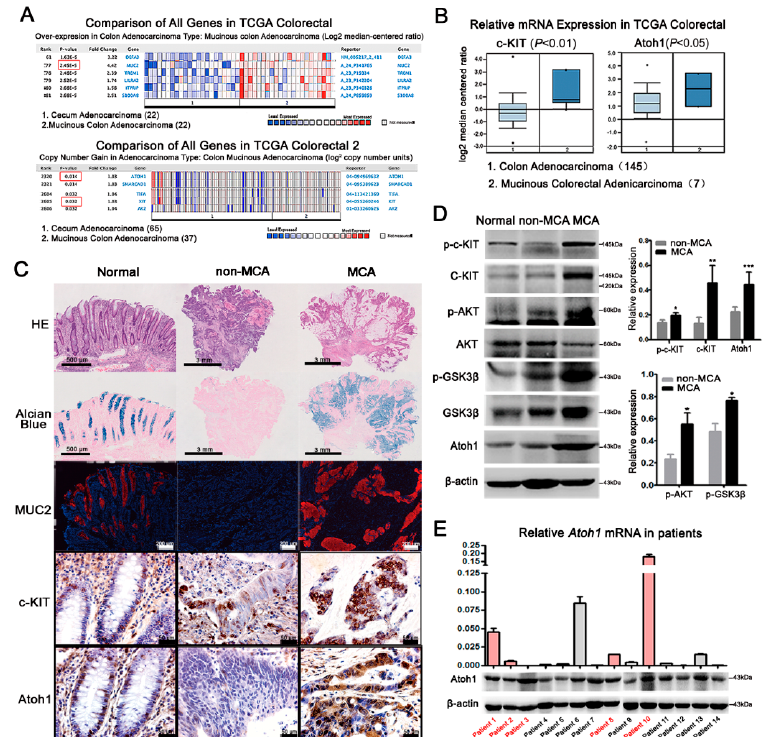
Figure 4. Expressions of c-KIT and Atoh1 in CRC patients. ( A ) Compared with cecum adenocacinoma ( n = 22), mRNA levels of MUC2 was markedly increased in mucinous colon adenocarcinoma ( n = 22) in TCGA Colorectal (red boxes, p -value). DNA copies of c-KIT and Atoh1 were significantly increased in mucinous colon adenocarcinoma ( n = 37) indicated by TCGA Colorectal 2; ( B ) the mRNA levels of c-KIT and Atoh1 were also elevated in MCA patients ( n = 145) compared with non-MCA ( n = 7) from TCGA Colorectal. p < 0.05 or 0.01; ( C ) according to the mucus area estimated under HE and Alcian blue staining, human CRC tissues were divided into non-MCA and MCA. Paratumoral normal tissues were used as controls. MUC2 was filled in goblet cells in normal colon and the main mucus component in MCA, while there was rare MUC2 in non-MCA tissues. Normally, c-KIT was expressed in the membrane while Atoh1 in the nuclei of epithelial cells, including goblet cells. Compared with non-MCA, c-KIT and Atoh1 were remarkably elevated in MCA, indicated by much more intensive immunostaining; ( D ) protein expressions of total c-KIT, p-c-KIT, and Atoh1 were clearly higher in MCA patients ( n = 5) than those in non-MCA patients ( n = 9) combined with an increased expression of p-AKT and p-GSK3 β . * p < 0.05, ** p < 0.01, *** p < 0.001; and ( E ) real-time PCR was performed to detect Atoh1 mRNA level in CRC tissues from 14 patients, including 5 MCA patients marked by red color. Glyceraldehyde-3-phosphate dehydrogenase (GAPDH) was used as the internal control. Normalized Atoh1 mRNA expression was shown in the column graph. Western blot showed the protein expression of Atoh1 which was consistent with its mRNA level except patient 3. All values are mean ± SEM of three independent experiments unless otherwise